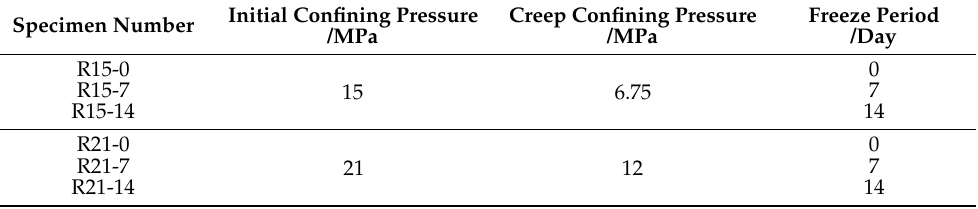
Table 1. Experimental